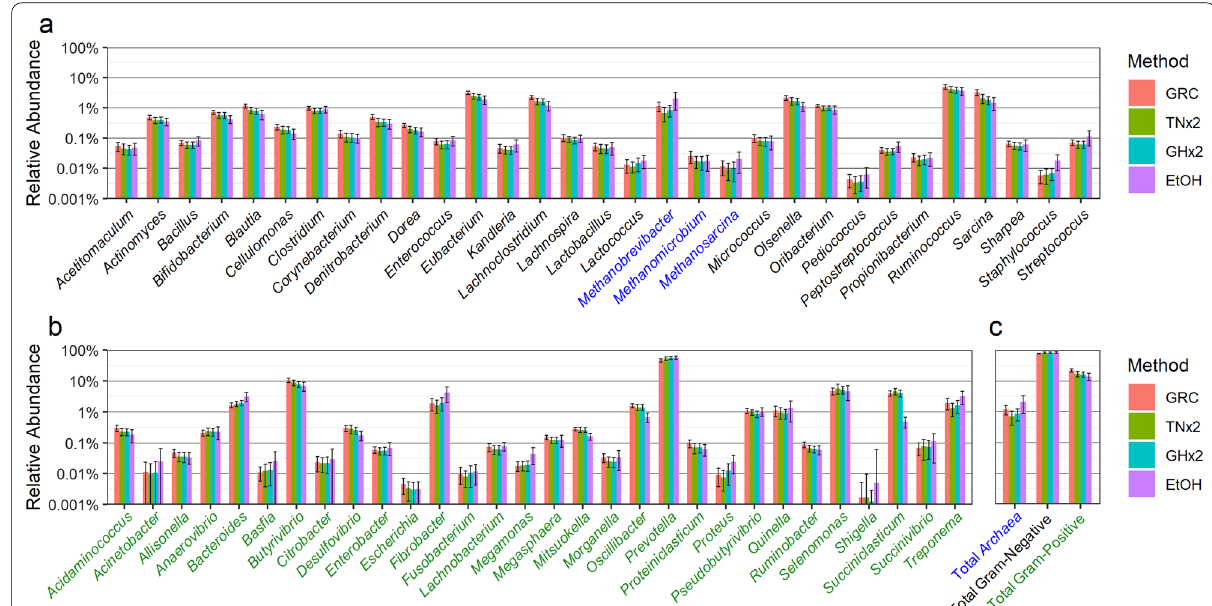
Fig. 3 Relative abundance of bacterial and archaeal taxa in samples stored and extracted by the GRC, TNx2, GHx2 and EtOH methods. a bacteria with a gram-positive wall (black) and archaea (blue). b bacteria with a gram-negative wall (green). c Total sum of archaea, gram-positive and gram-negative taxa. Error bars represent one standard deviation of the raw ±